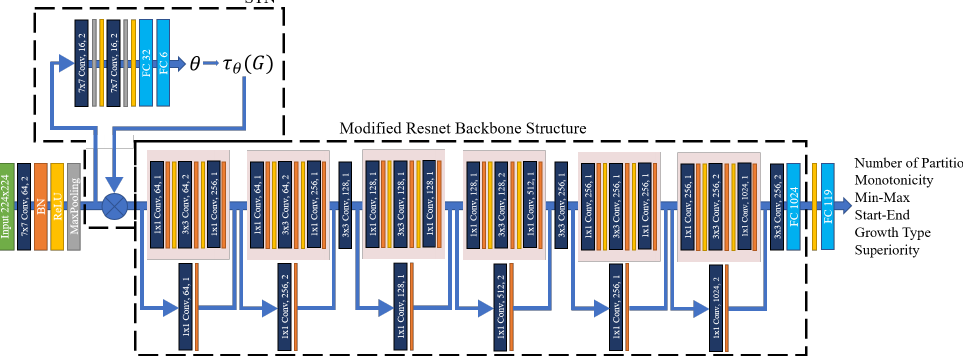
Figure 5. Architecture of CU-STN ( θ : transformation parameter of STN for grid generator). Table 4. Hyper-Parameter Settings (In.: Increasing, De.: